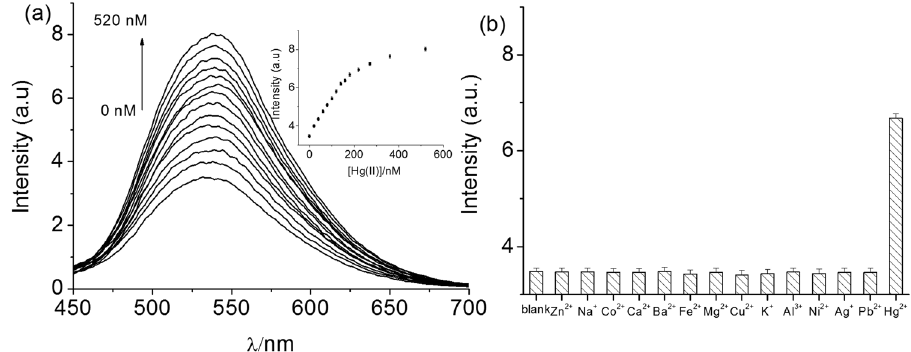
Figure 5. ( a ) Luminescence emission spectra of 1.0 μ M complex 1 in Tris-HNO 3 buffer solution (pH 7.0) containing 0.4 μ M Ag nanoparticles and different concentrations of Hg(II) (from bottom to top: 0, 20, 40, 60, 80, 100, 120, 140, 160, 180, 220, 270, 360, and 520 nM). ( b ) Luminescence intensities of the 1 /AgNP system (1.0 μ M 1 and 0.4 μ M AgNPs in Tris-HNO 3 at pH 7.0) in the presence of Hg(II) (180 nM) or interfering species (1 μ M).